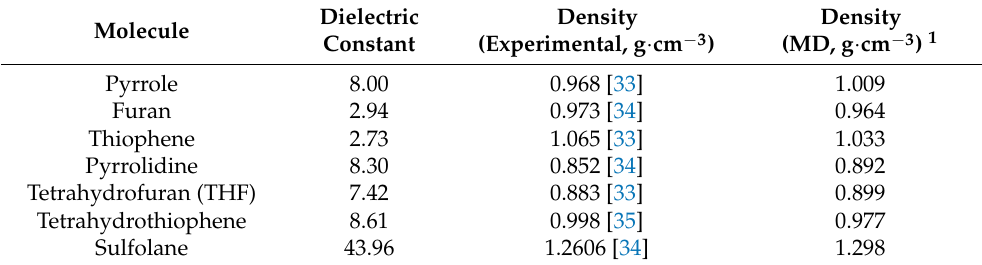
Table 1. Density (standard, and MD-computed) and dielectric constants used in this work for seven